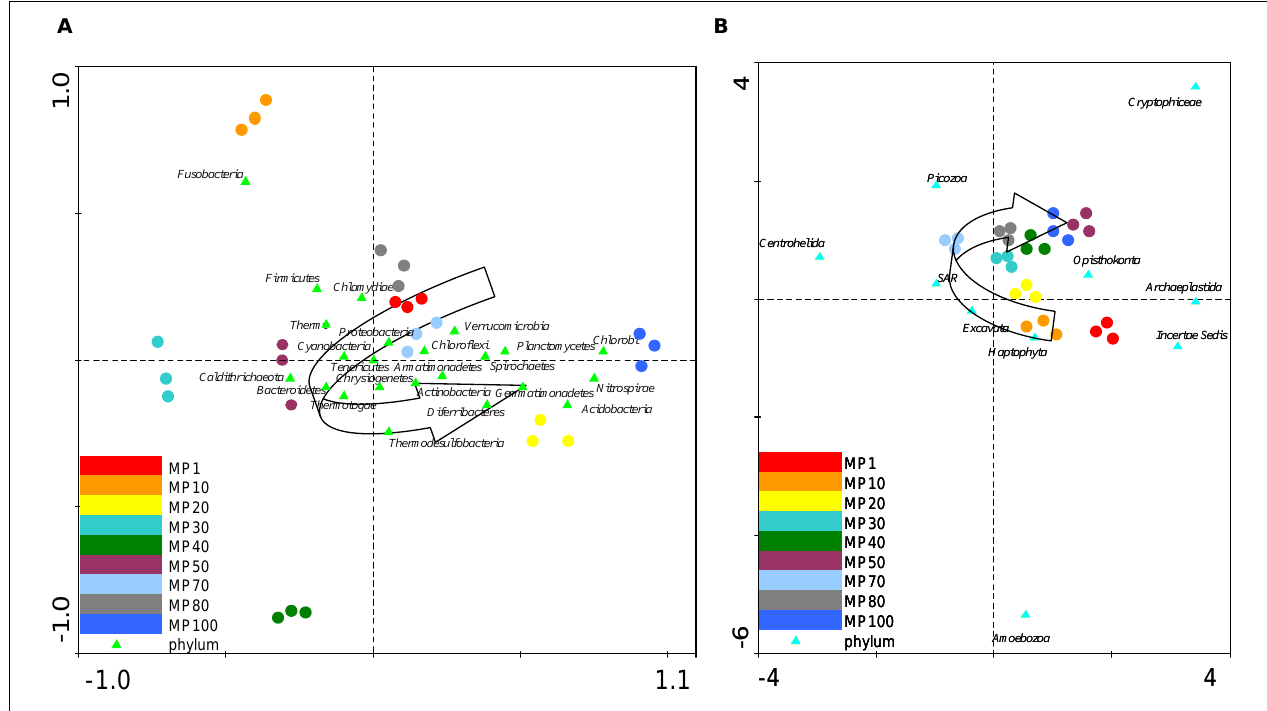
FIGURE 3 | Multivariate statistical analysis. (A,B) DCA: The relative abundances of the (A) bacterial and (B) eukaryotic phyla from glacier samples were compared to find their age gradient. The diagram displays triangles that represent phyla and circles representing samples. Semicircular arrows show how samples follow a trend in the distribution of microorganisms along the age gradient. The axes are scaled in standard deviation units.